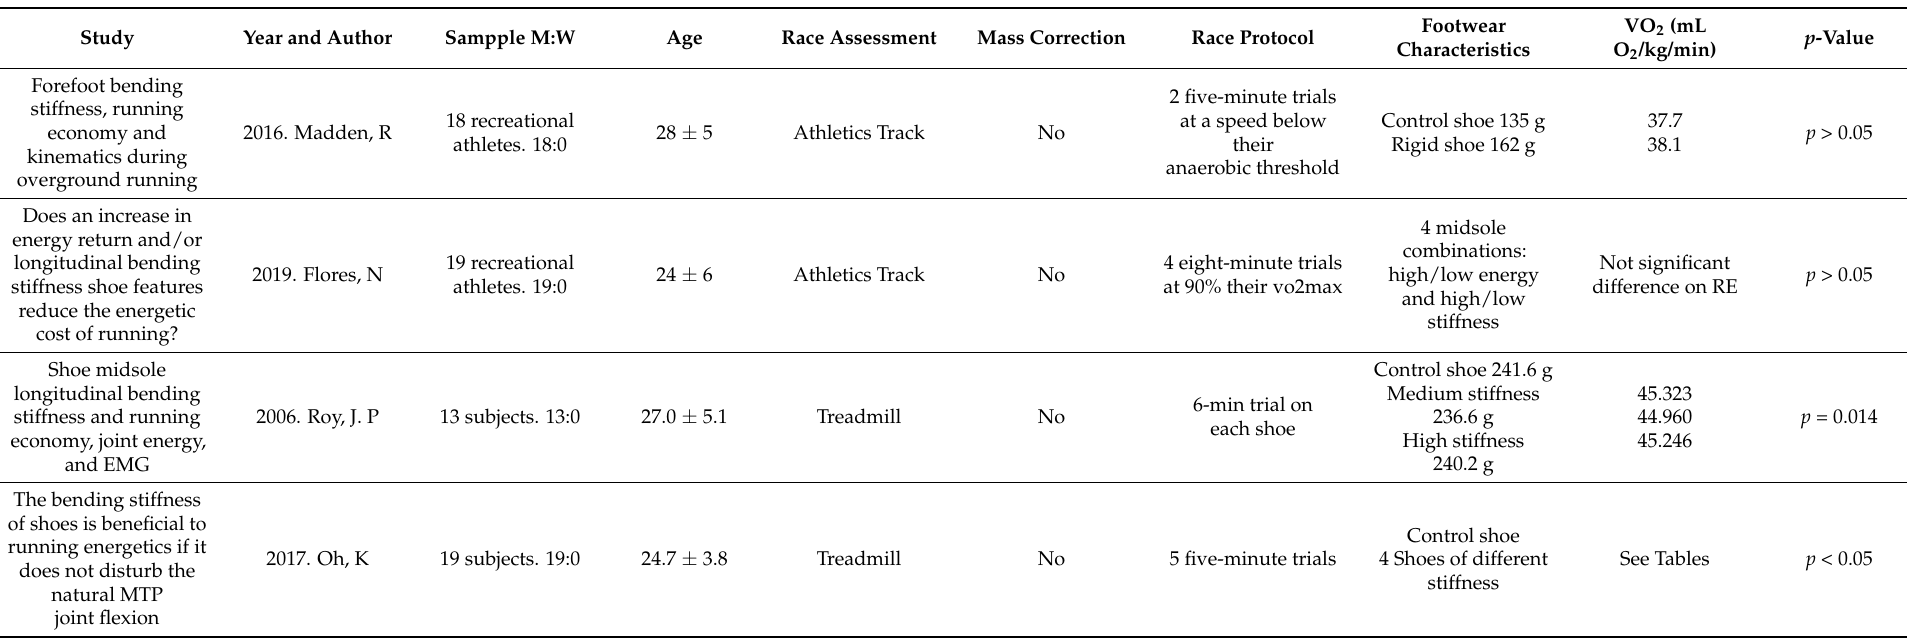
Table 4. Longitudinal Bending